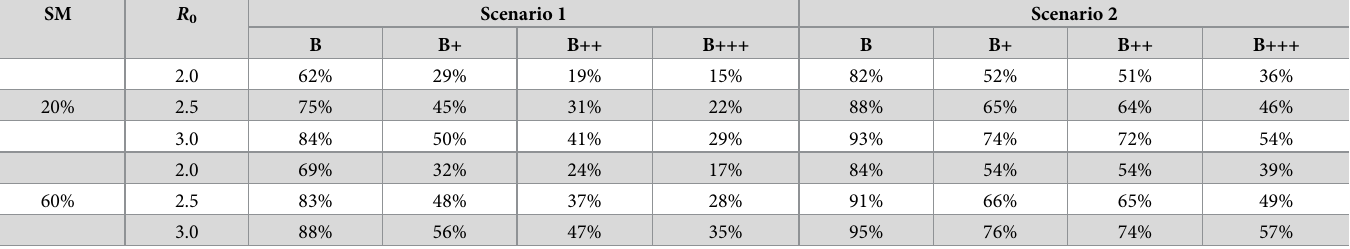
Table 4. Attack rates for combinations of NPIs under different modeling assumptions. “SM” is short for “shedding models”, “B” is short for “Baseline,” in Scenario 1 the infection source is a dialysis patient and in Scenario 2 the infection source is a HCP. SM R 0 Scenario